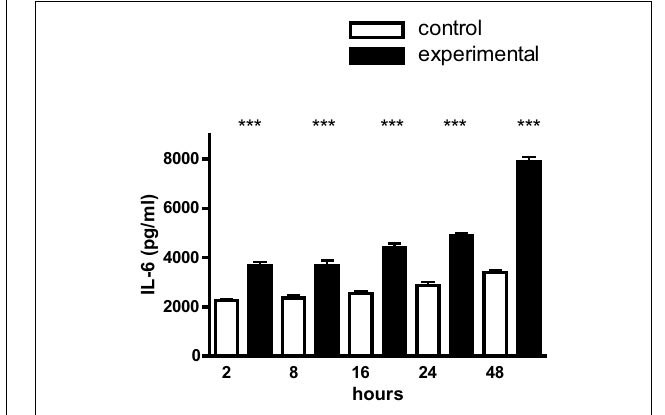
FIGURE 2 | IL-6 production by mouse calvarial osteoblasts . Osteoblasts in monolayer culture were subjected to a cyclic tensile strain (6s every 90s) for 2–48h and the culture media assayed for IL-6 by an ELISA. Results are mean ± SEM for 10 cultures. ***Experimental significantly greater than control. P <